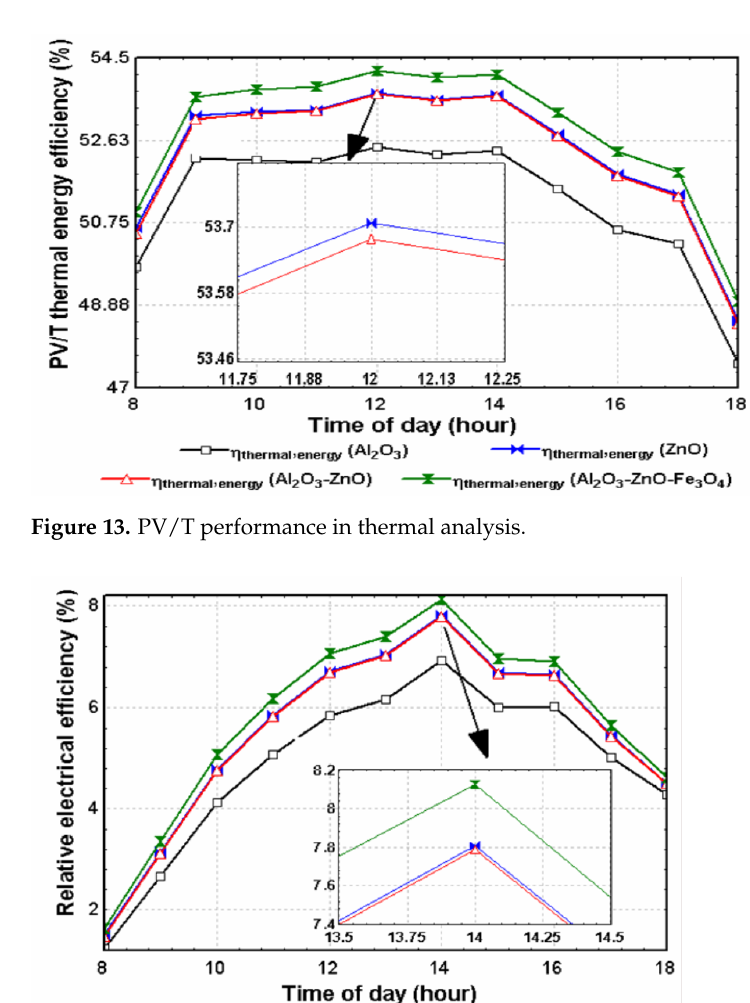
Figure 12. Electrical efficiency of PV/T system.